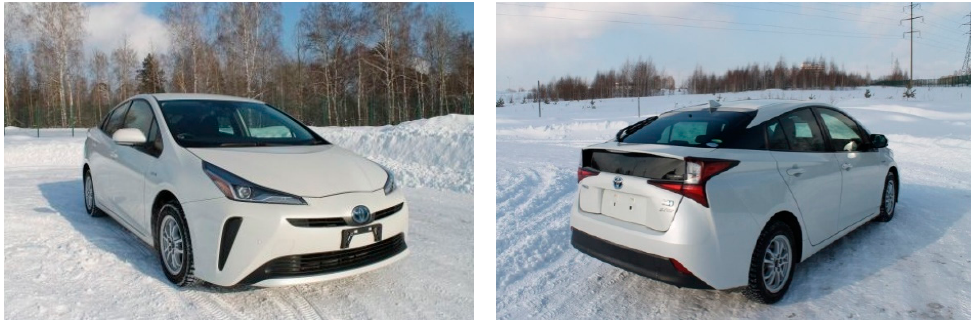
Figure 3. Car model chosen for the experiment.